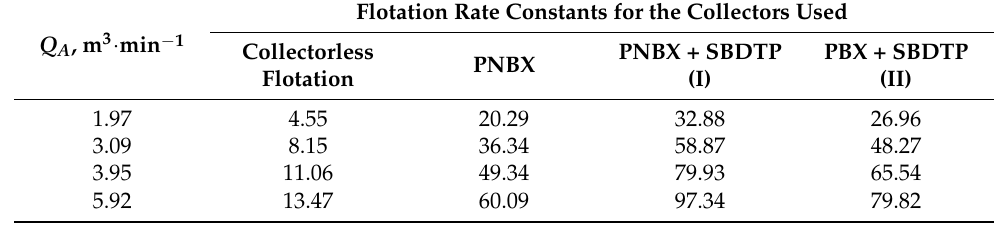
Table 7. Established flotation rate constants for arsenopyrite.